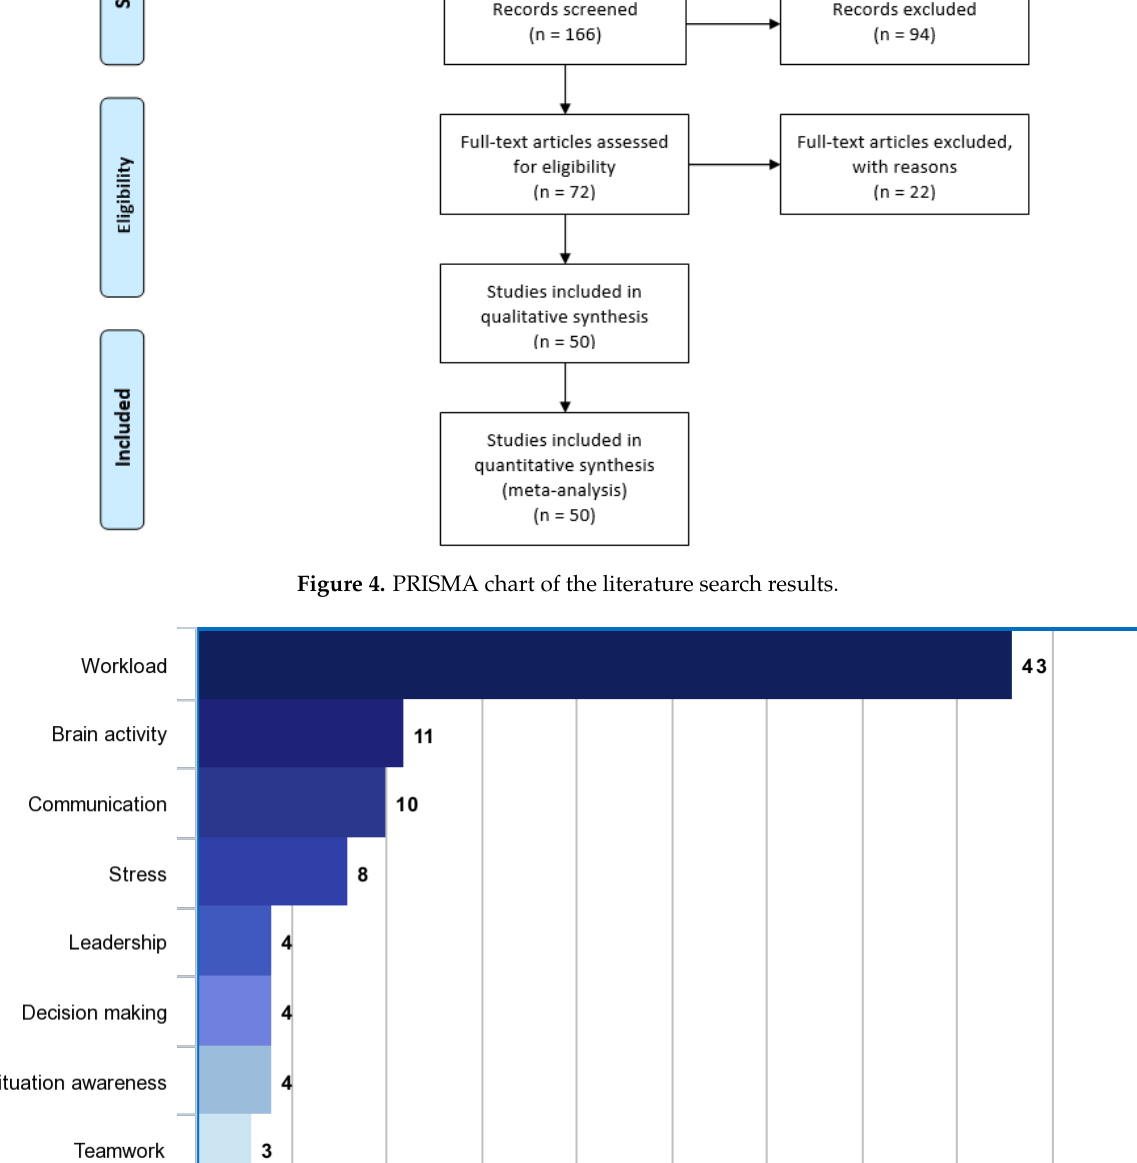
Figure 5. Bar chart of the literature search results. Each bar refers to the number of references identified and examined the particular feature/non-technical skill in